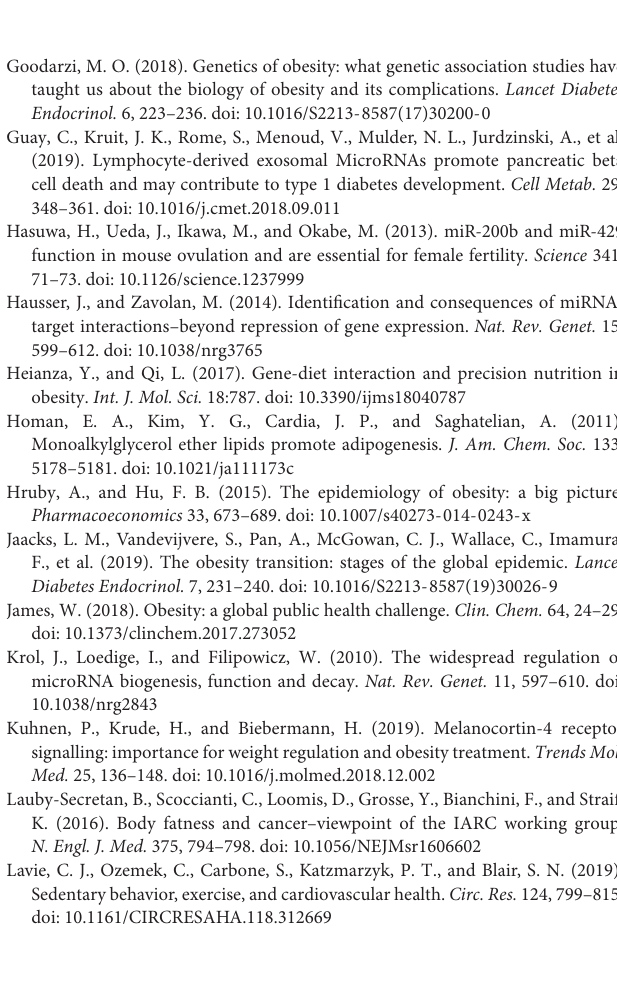
Supplementary Figure 1 | The first nucleotide bias of small RNA. Supplementary Table 1 | Primers sequence information. Supplementary Table 2 | Data quality statistics and mapping efficiency. Supplementary Table 3 | The enriched pathways related to fat deposition. Supplementary Table 4 | The top-enrich pathways for DEGs in DAVID 6.8 platform. Supplementary Table 5 | The lipid metabolism-related pathways enriched in IPA platform. Supplementary Table 6 | miRNA count in small